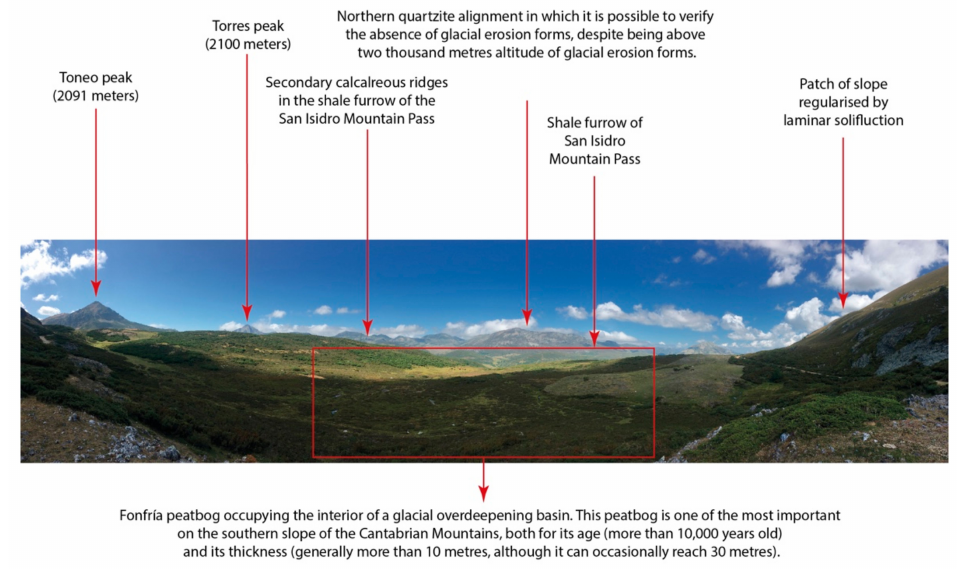
Figure 17. 360 ◦ photograph from the seventh POI. Photograph by the authors. Focus with camera on Figure through Onirix site or use the link